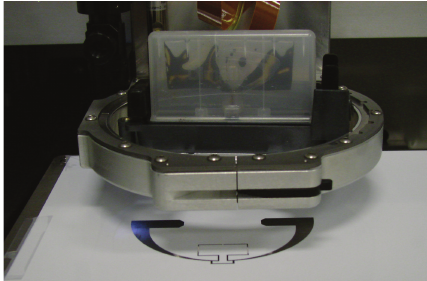
Figure 10: Inkjet printed RFID antenna.